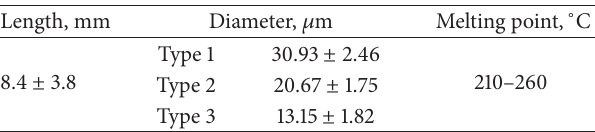
Table 1: Properties of